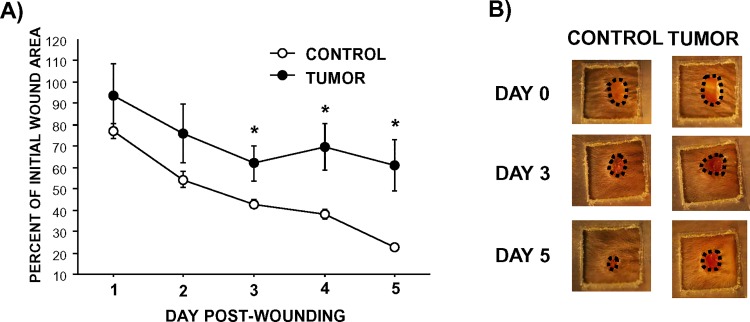
Tumors delay dermal wound closure.(A) Average percent (±SEM) of original 3.5 mm dermal excisional wound size analyzed over 5 days using digital photography. (B) Representative photographs of wounds over time. Unhealed skin is circled. n = 10/group; *p<0.05.